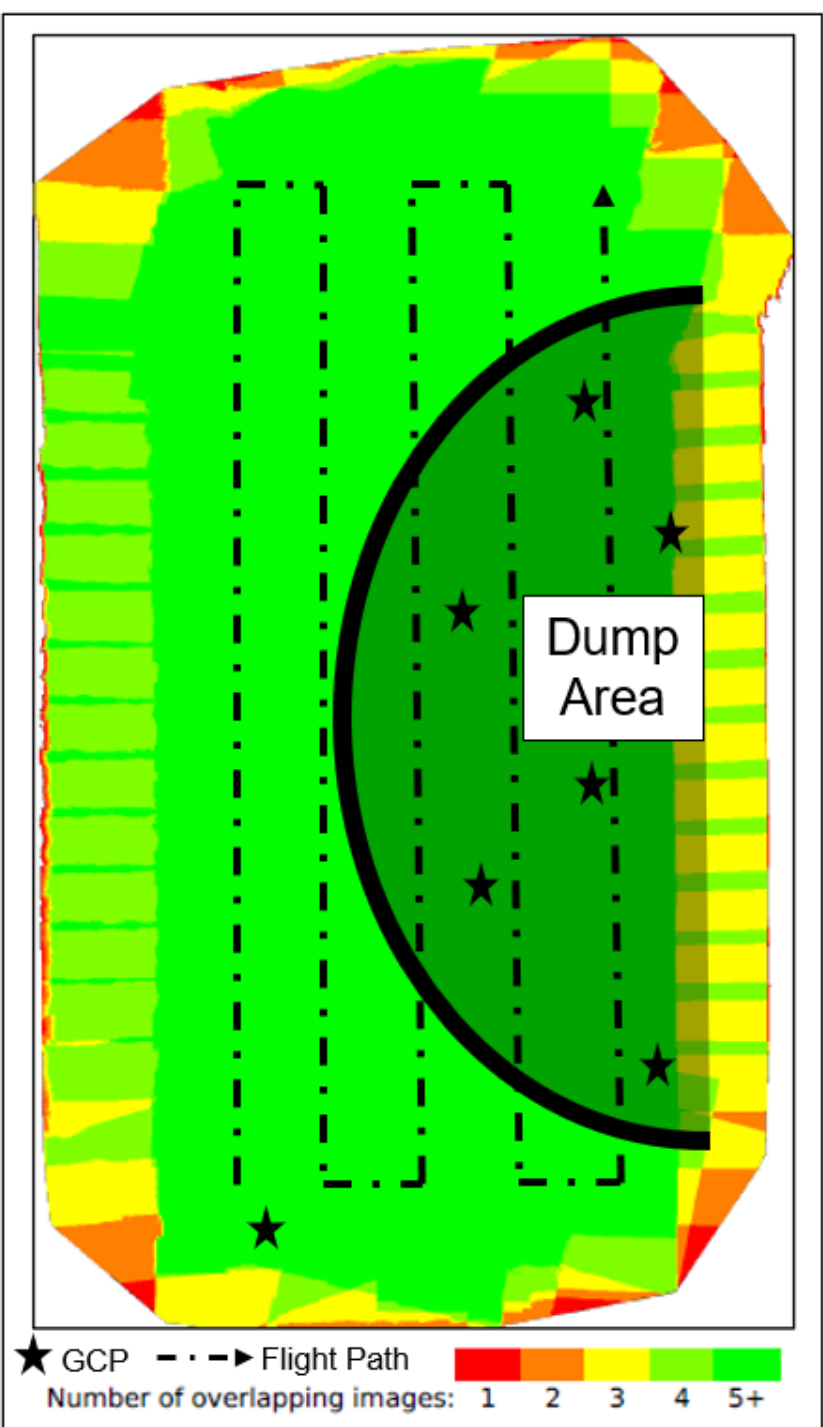
Figure 1. Top (XY Plane) view of a typical flight plan. Stars represent locations of ground control points (GCPs). The dashed line shows the flight path of the UAV. The shaded area is an approximation of the dump area. The color represents the number of overlapping images in accordance with the scale